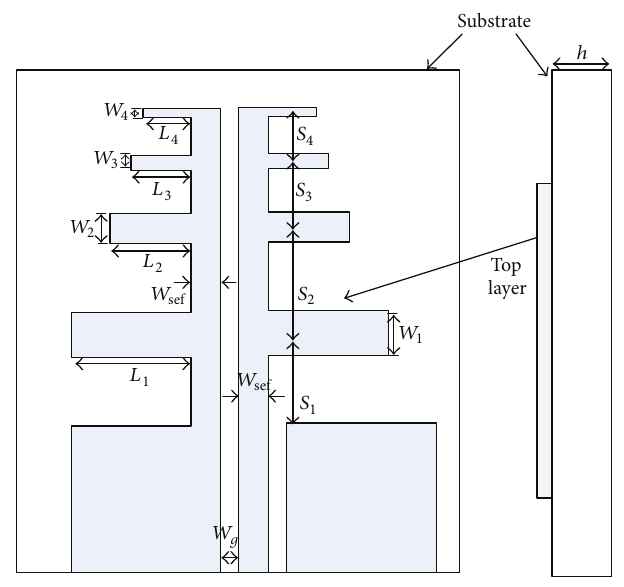
Figure 1: Geometry of the proposed CPW PLPDA